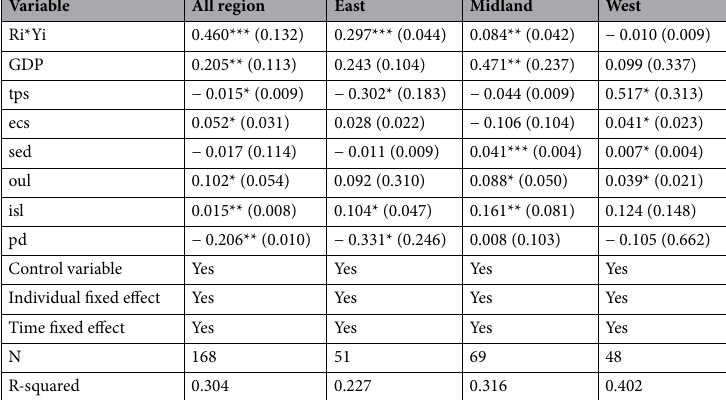
Table 6. The result of the PSM-DID.